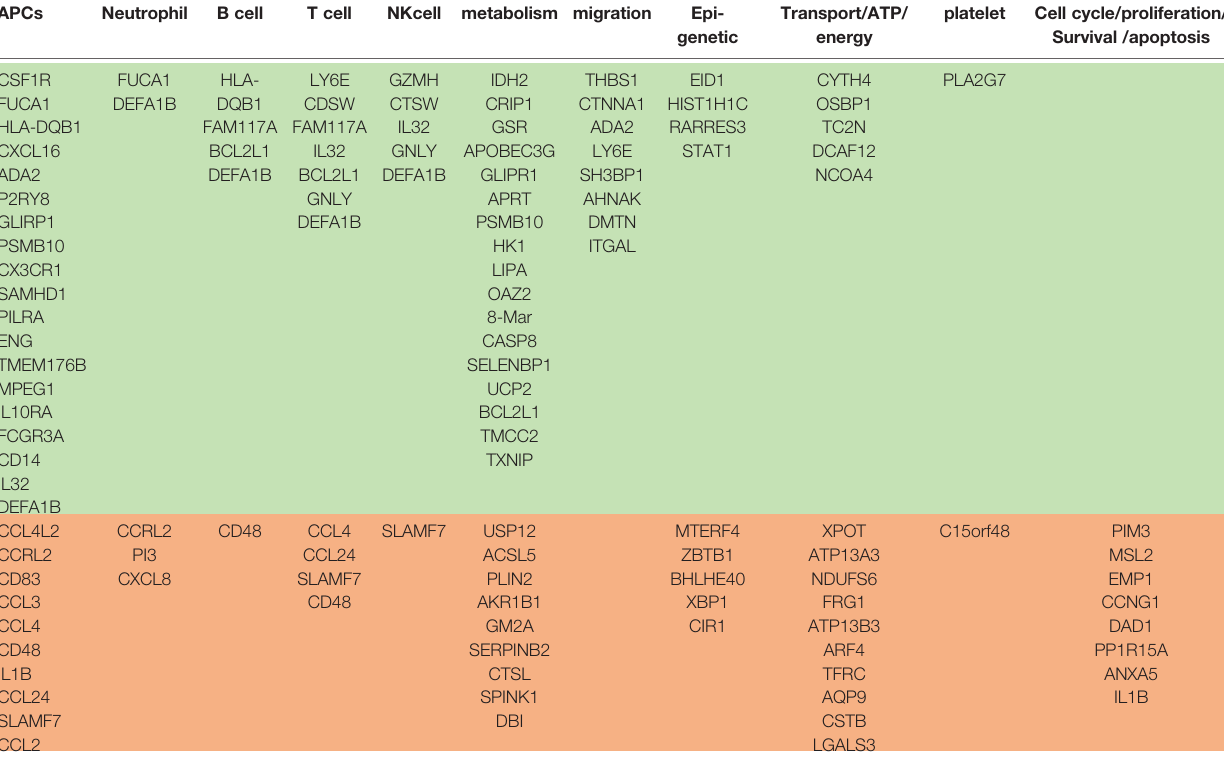
TABLE 1 | The effects of LMS on immune cells in patients with